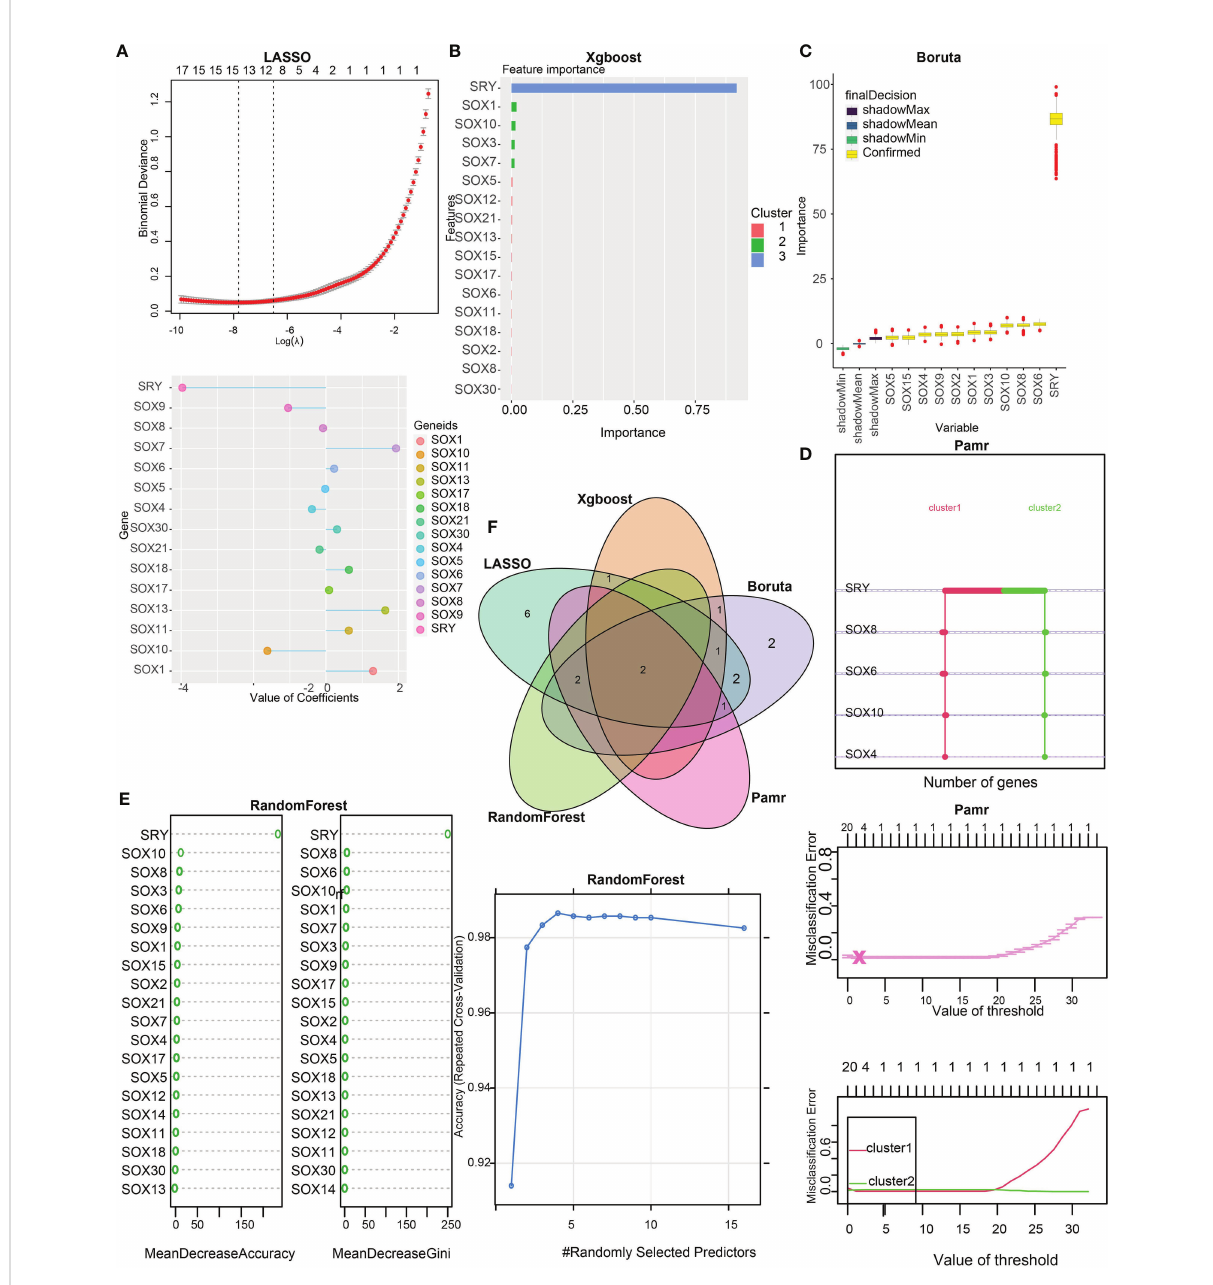
FIGURE 4 Identi fi cation of SOX10 as a prognostic gene by machine learning. (A) The assessment of the weighted importance of genes between two clusters by the LASSO-LR algorithm. (B) The evaluation of feature importance of genes between two clusters by the XGboost algorithm. (C) The selection of all relevant features of genes between two clusters by the Bruta algorithm. (D) The assessment of genes between two clusters by the Pamr algorithm. (E) The evaluation of genes between two clusters by the random forest algorithm. (F) Validation of the intersection of glioma prognostic genes from LASSO, Xgboost, Boruta, Pamr, and Random